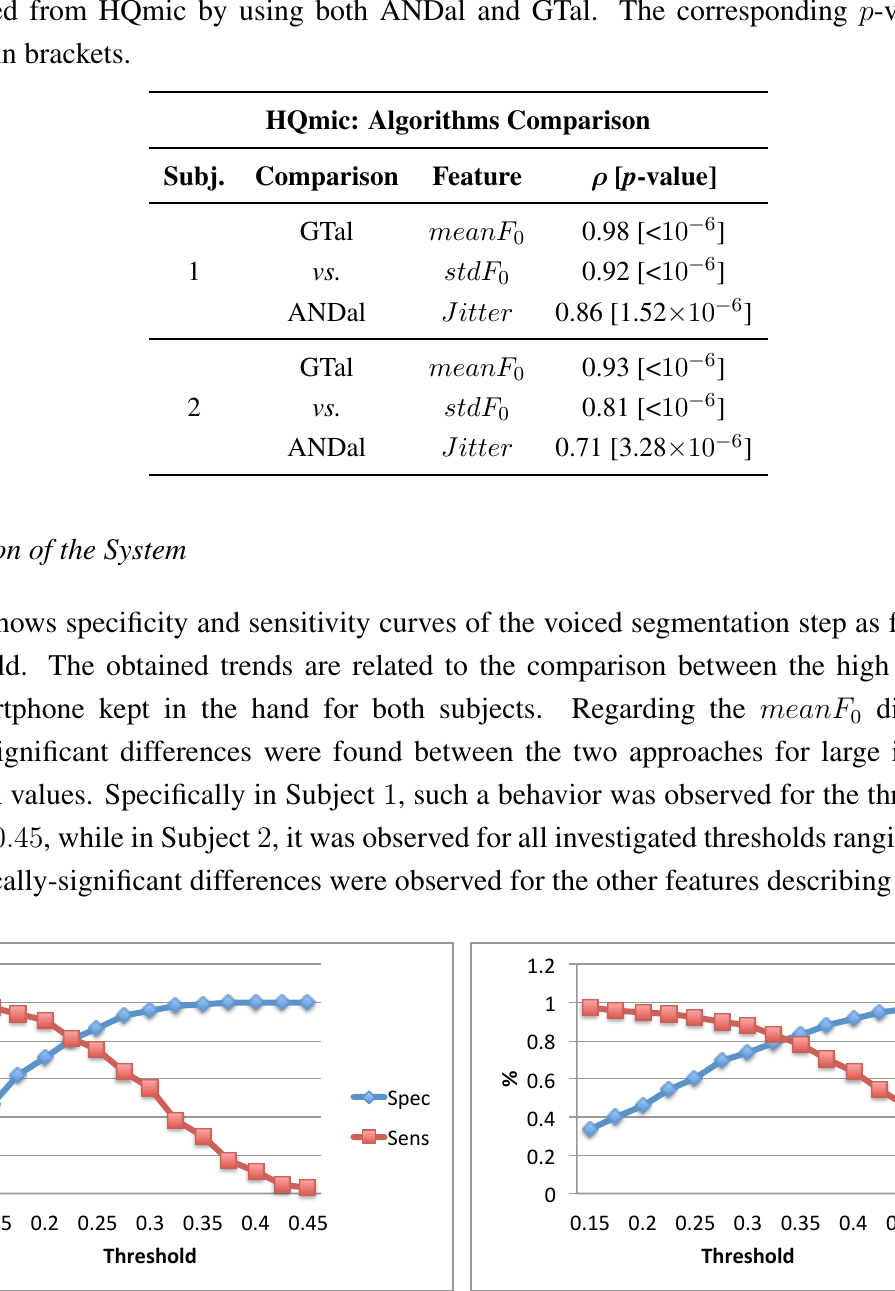
Figure 3. Specificity and sensitivity trends of voiced segmentation in Subject 1 ( left ) and Subject 2 ( right ) regarding the comparison HQmic + GTal vs. SPmic